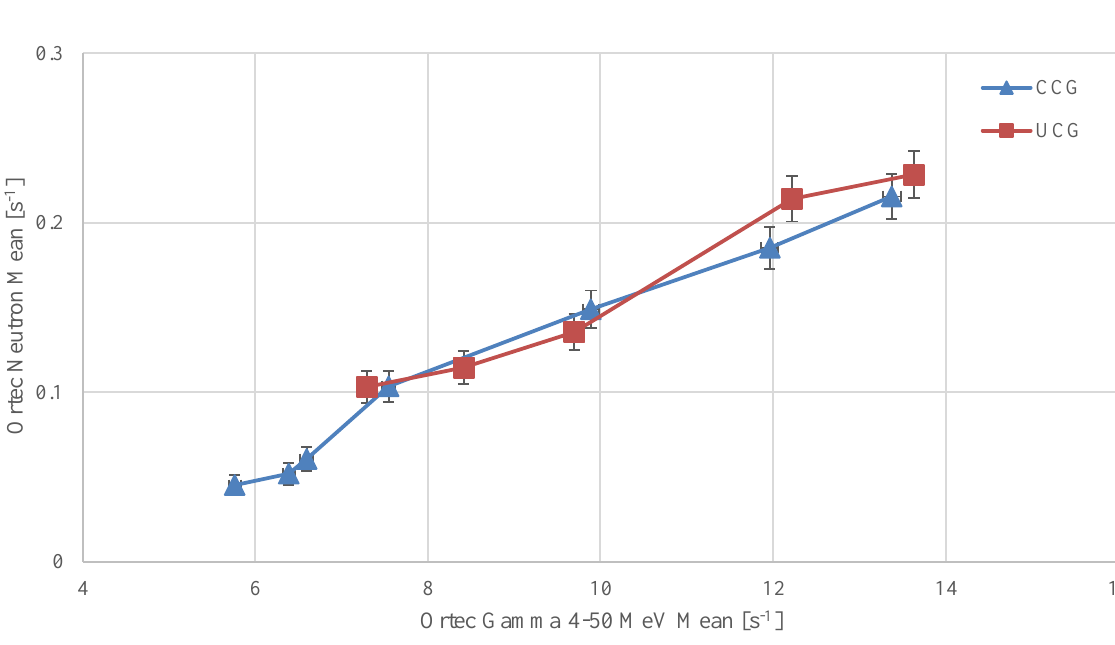
Figure 7. The mean Thermo PackEye neutron count rate at each location in each parking garage plotted as a function of concrete thickness above the detector system. The data were collected continuously over 15-20 minutes and had a five second rolling average applied before calculating the mean. 1-σ error bars are shown, but some of them may be obscured by the data markers.